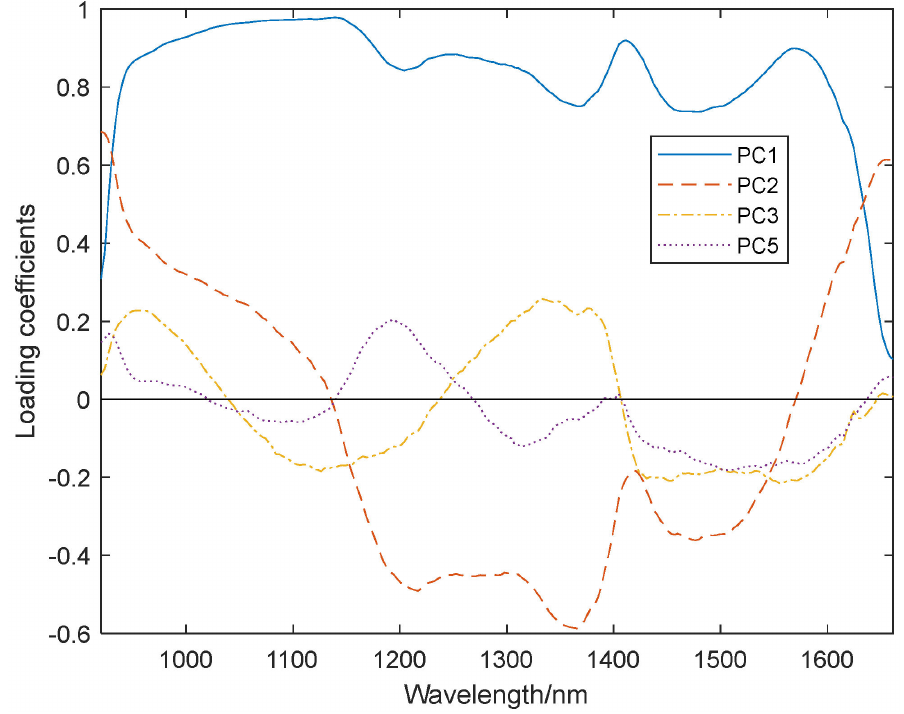
Figure 5. Loading coefficients of PCs after XY335 hyperspectral image by PC